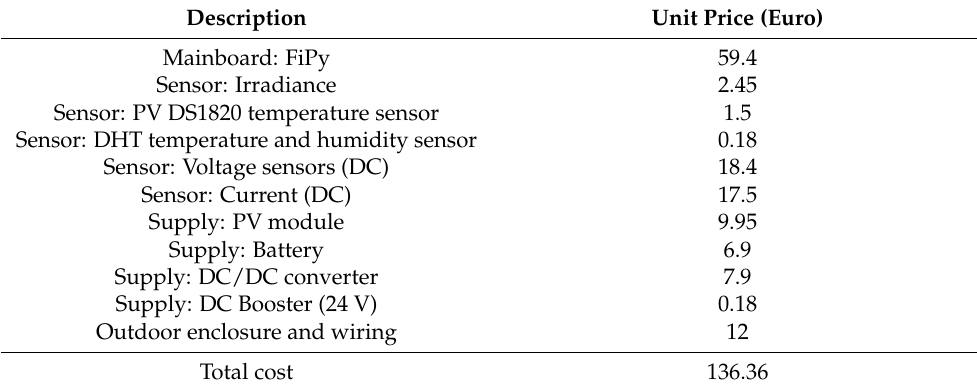
Table 4. PV monitoring node